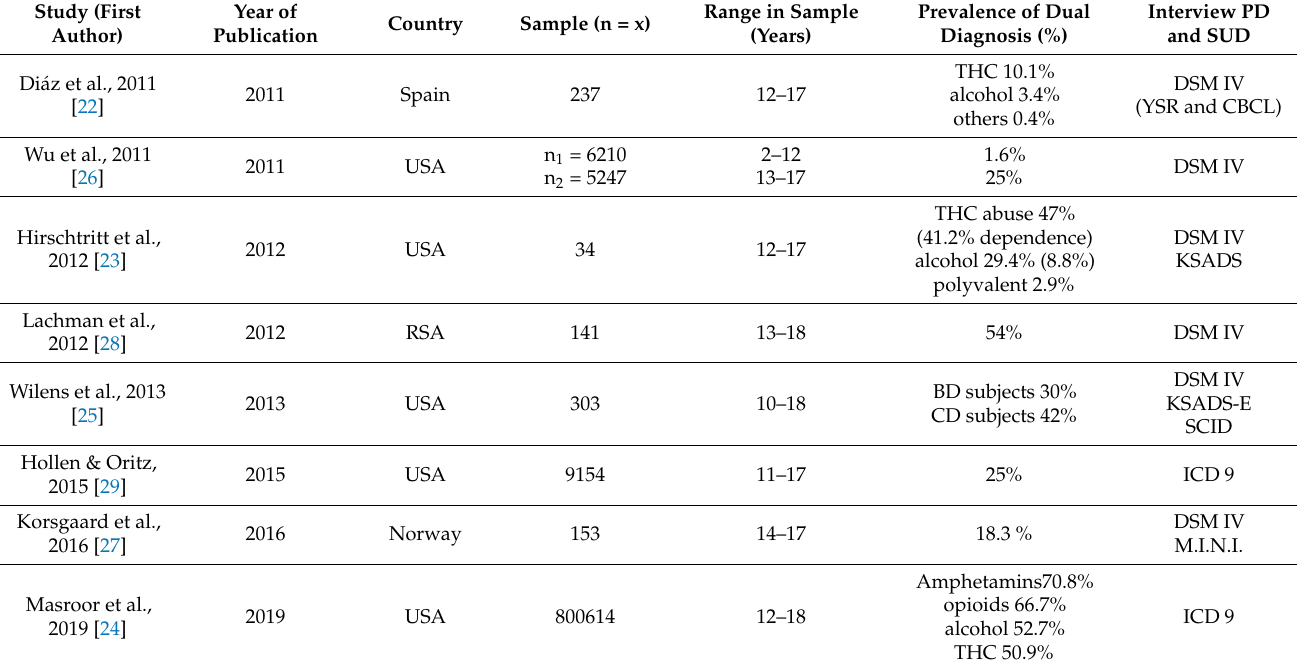
Table 1. Papers included in the study.